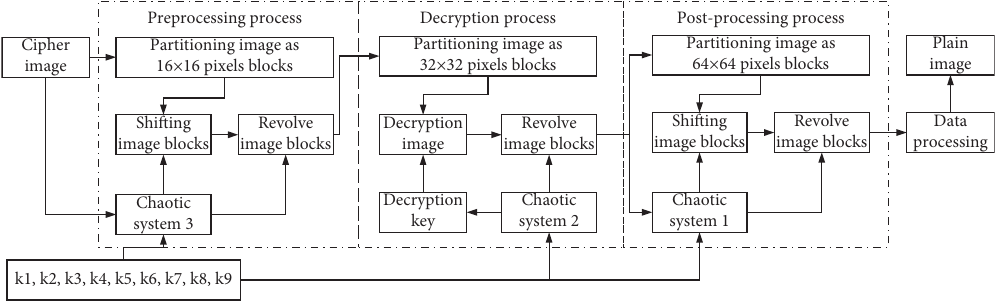
Figure 4: Decryption